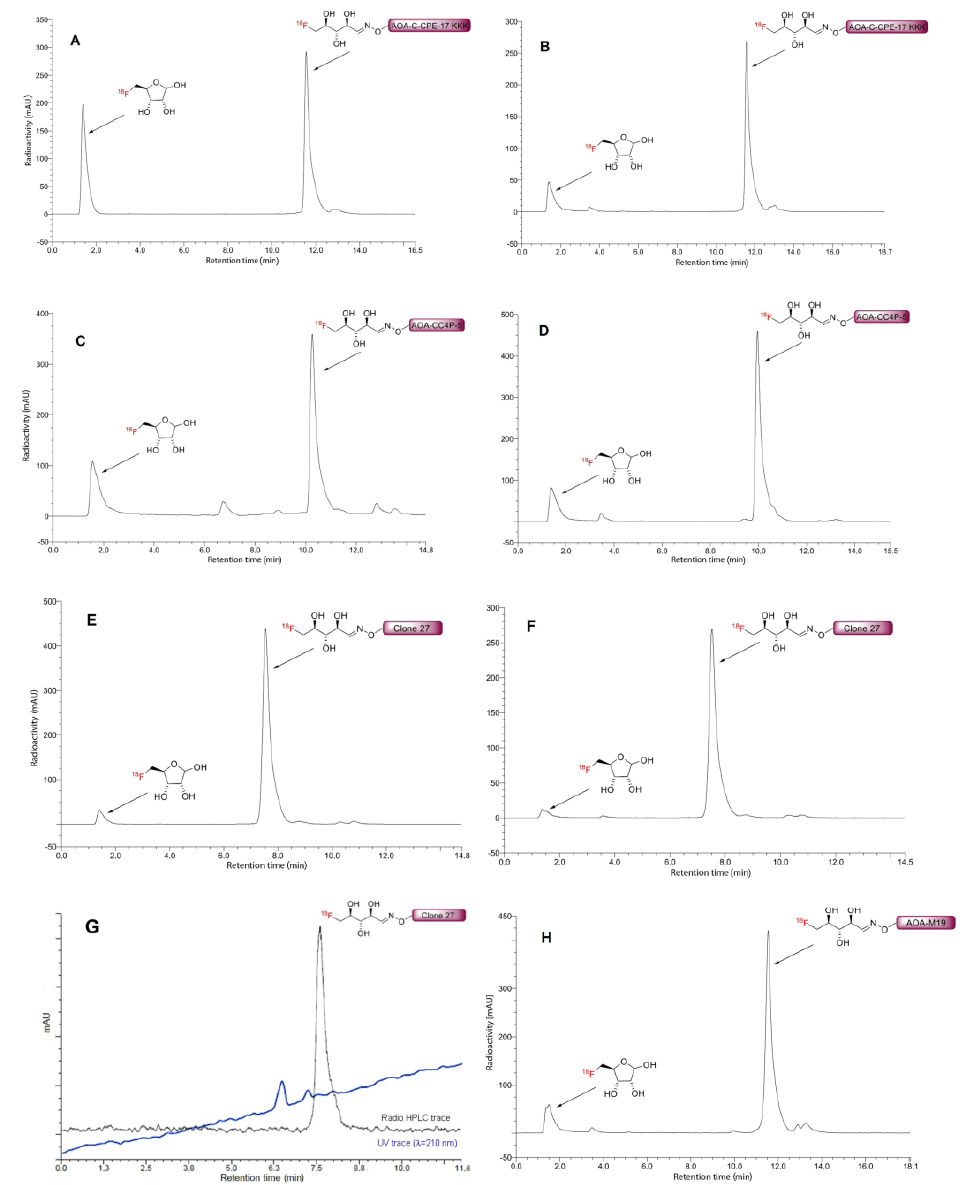
Figure 6. HPLC chromatograms of the crude 5-[ 18 F]FDR-AOA-peptide conjugates prepared using ammonium acetate (( A , C , E ); reaction conditions I) and anilinium acetate (( B , D , F , H ); reaction conditions II) as well as purified 5-[ 18 F]FDR-AOA-Clone 27 ([ 18 F] 11 , ( G )). Reaction conditions: I: 0.2